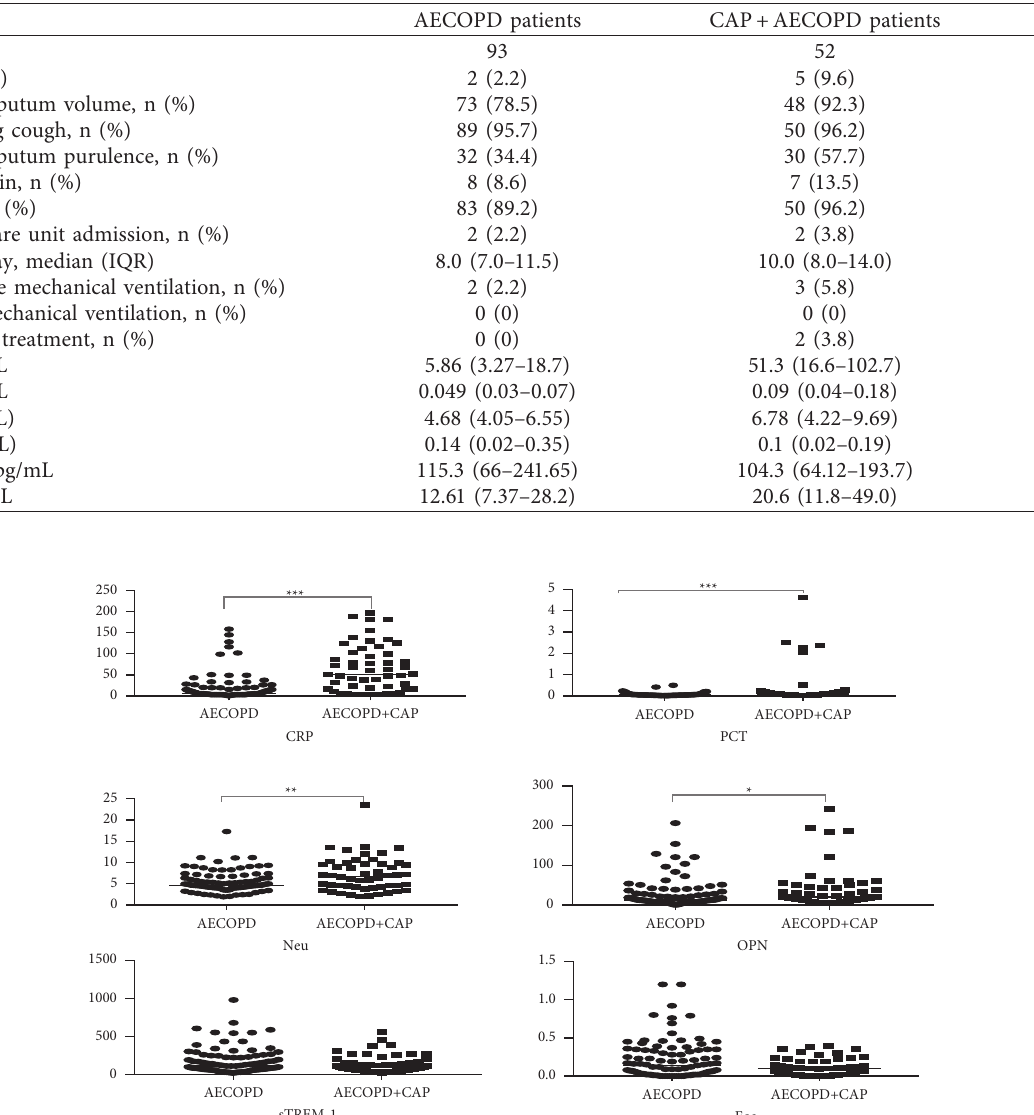
Table 2: Clinical parameters and biomarker differences evaluated at admission.